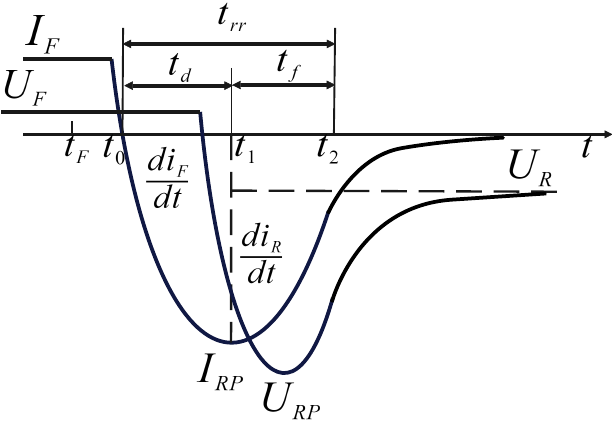
Figure 2. Reverse recovery voltage and current waveform of the rectifier tube.